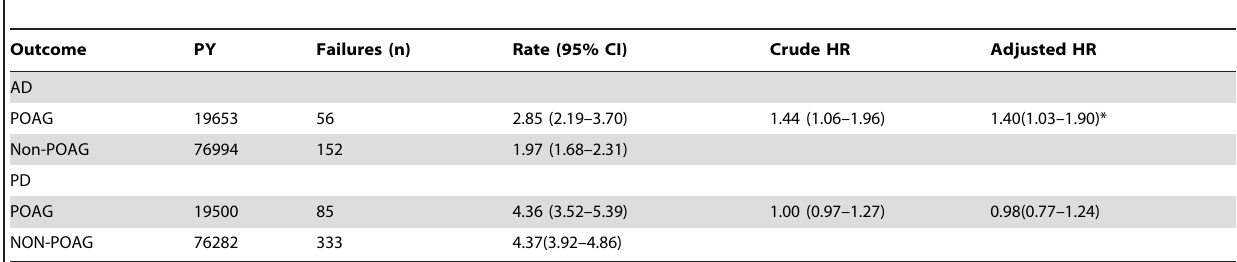
Table 2. The incidence rate per 1000 person-years of AD and PD among patients with and without POAG.